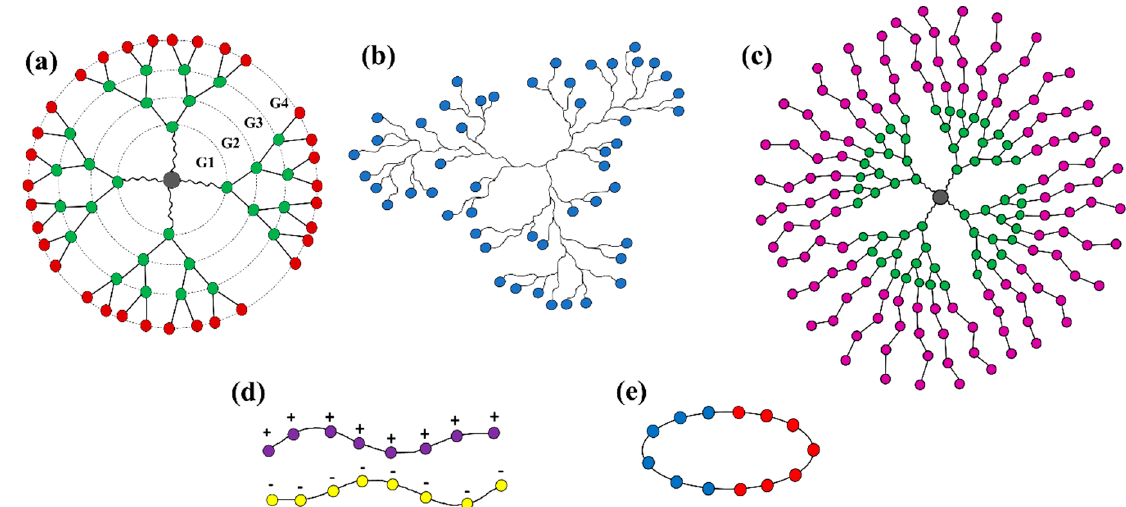
Figure 1. Schematic structure of ( a ) “star burst” dendrimer (of generation 4, G4), ( b ) hyperbranched polymer, ( c ) dendrimer multi-arm copolymer, ( d ) polyelectrolyte (polycation and polyanion) chains, and ( e ) cyclic polymer.